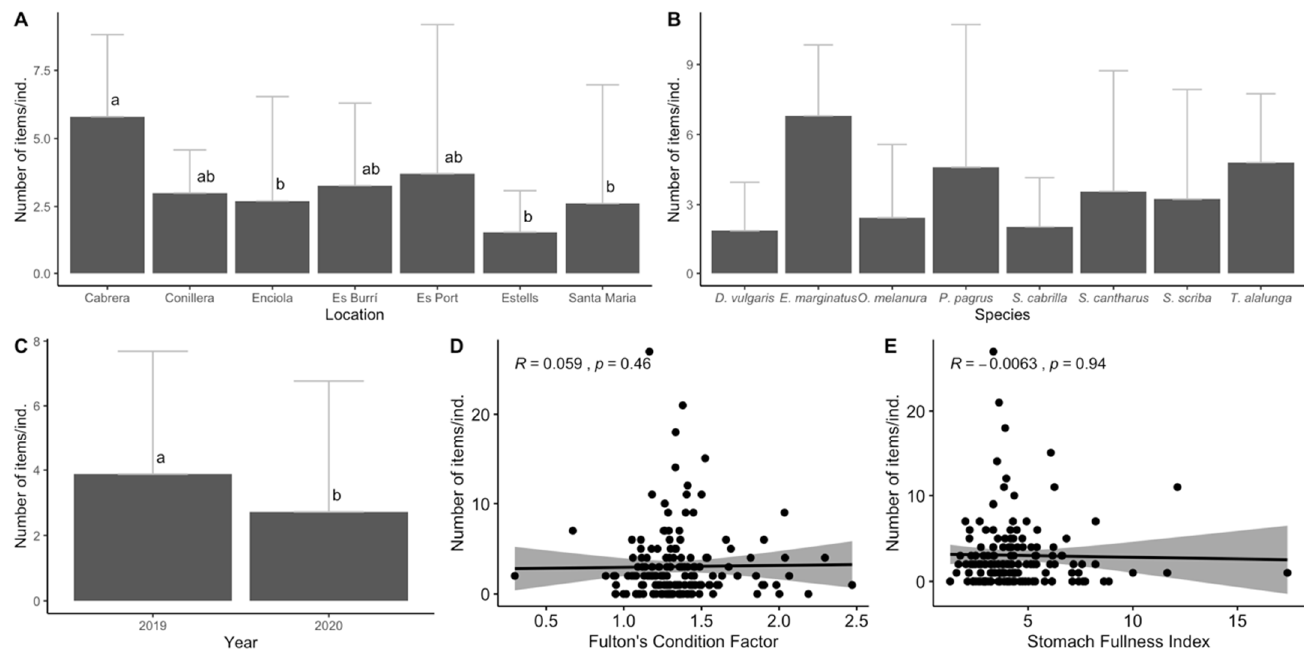
Figure 4. Results for the ingestion of anthropogenic particles (AP) in fish samples according to location ( A ), species ( B ) and year ( C ), as well as the Spearman rank correlation between Fulton’s condition factor ( D ) and the stomach fullness index ( E ). The error bars for ( A – C ) indicate a 95% confidence interval, and significant differences are indicated by different letters. The significance level was established at p < 0.05.